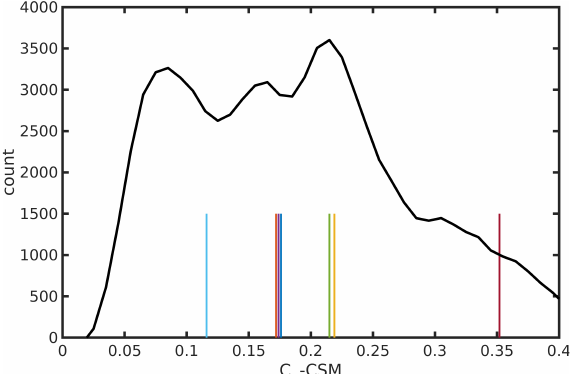
Figure 9. Distribution of C 2 -CSM symmetry deviation parameter from N3 4 − trajectory in water solution. Values of the medoid structures from trajectory clustering analysis are also shown as vertical bars (with arbitrary heights). The color code is uniform with that of Figure 7.